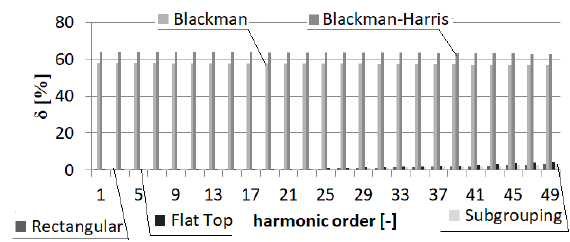
Fig. 4. Distribution of relative error of odd harmonics for the triangular test signal (49.9 Hz).